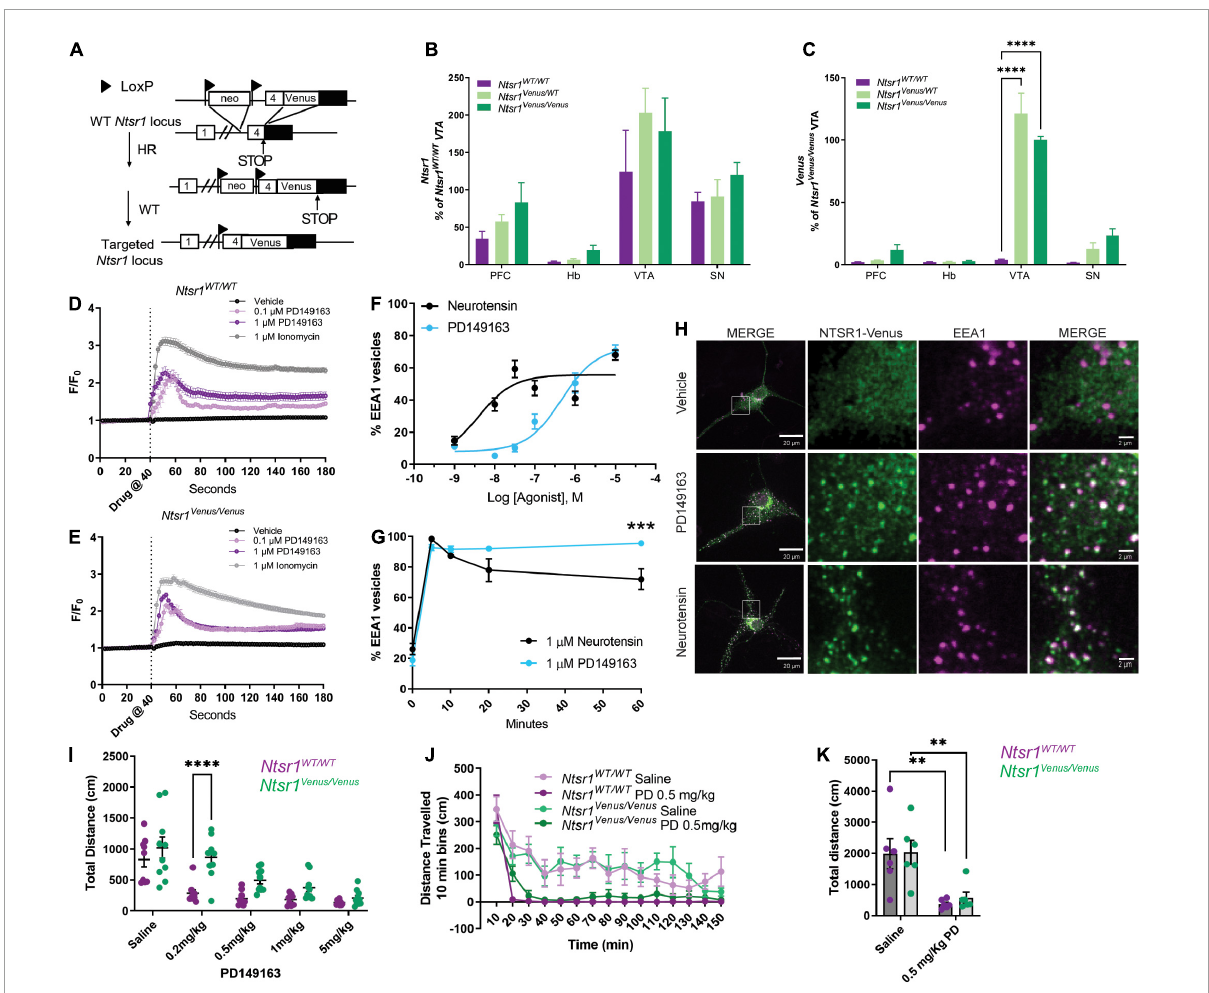
FIGURE2 NTSR1-Venus knock-in mouse generation and functional characterization. (A) Scheme of NTSR1-Venus knock-in mouse generation. Briefly, Venus was knocked-in at the C-terminus of Ntsr1 at the endogenous gene locus. (B,C) mRNA transcript expression is shown across mouse brain regions–prefrontal cortex (PFC), habenula (Hb), ventral tegmental area (VTA), and substantia nigra (SN) in Ntsr1 WT / WT , Ntsr1 KI / WT , and Ntsr1 KI / KI ( n = 3–5 animals per group). (B) Ntsr1 gene expression. (C) Venus gene expression. ∗∗∗∗ p < 0.0001 via 2way ANOVA with a Dunnett’s post-hoc test [significant effect by brain region F ( 3 , 39 ) = 78.35; p < 0.0001; significant effect by genotype F ( 2 , 39 ) = 30.01; p < 0.0001, significant interaction F ( 6 , 39 ) = 18.65; p < 0.0001]. (D,E) Intracellular Ca2+ response was measured in hippocampal neurons from either Ntsr1 WT / WT (D) or Ntsr1 Venus / Venus (E) mice. Hippocampal neurons were treated with vehicle, 0.1 µ M, 1 µ M PD149163, or 1 µ M Ionomycin. Drug was added at 40 s. n = 11–148 cells per condition, each cell was normalized to baseline for the individual cell. (F–H) Agonist profiling by monitoring internalization of NTSR1-Venus in hippocampal primary neurons from Ntsr1 Venus / Venus mice treated with 1 µ M neurotensin or PD149163. The % EEA1 vesicles was calculated by taking the ratio of Venus to EEA1 puncta. (F) Dose-response curves. Neurons were treated with the indicated concentrations of PD149163 or neurotensin and fixed after 5 min. n = 20–23 neurons per condition. (G) Internalization time-course. Hippocampal neurons from Ntsr1 Venus / Venus mice were treated with 1 µ M PD149163 or neurotensin and fixed at indicated timepoints. 0 min received no treatment. n = 13 neurons per condition. ∗∗∗ p = 0.0002 via 2way ANOVA with a Sidak’s post-hoc test [significant effect by time F ( 4 , 111 ) = 122.1; p < 0.0001], significant effect by drug F ( 1 , 111 ) = 5.350; p = 0.0226 with a significant interaction F ( 4 , 111 ) = 5.690; p = 0.0003. (H) Representative images of NTSR1-Venus internalization in hippocampal neurons from Ntsr1 Venus / Venus mice. Cells were treated with vehicle, or NTSR1 agonists 1 µ M PD149163 or neurotensin for 60 min and fixed and stained with anti-Venus (green) or EEA1 (magenta). White boxes indicate 10x magnified area. Scale bars are 20 µ m for the macro view and 2 µ m for the magnified view. (I) 30 minutes following i.p. injection of NTSR1 agonist, PD149163, or saline dose-response locomotor activity effects were assessed by measuring horizontal movement (cm) during 150 min in activity boxes. n = 9 or 10 for Ntsr1 WT / WT and Ntsr1 Venus / Venus mice, respectively. ∗∗∗∗ p < 0.0001 for 0.2 mg/kg Ntsr1 WT / WT vs. Ntsr1 Venus / Venus via 2way RM ANOVA Sidak’s multiple comparisons test [Dose significant effect F ( 4 , 68 ) = 31.61; p < 0.0001, Genotype significant effect F ( 1 , 17 ) = 12.91; p = 0.0022, significant interaction F ( 4 , 68 ) = 3.242; p = 0.0170]. (J) Locomotor activity was measured 30 min following i.p. injection of saline or 0.5 mg/kg PD149163 in tagged and untagged NTSR1 animals. Data shown in 10 min bins of distance traveled. 2way ANOVA Sidak’s multiple comparisons test was not significant for genotype effect [ F ( 1 , 10 ) = 0.005494; p = 0.9424 saline, F ( 1 , 10 ) = 1.261; p = 0.2877 PD 0.5 mg/kg]. (K) Total distance traveled in animals treated with 0.5 mg/kg PD149163 compared to saline treated animals. n = 6 for Ntsr1 Venus / Venus and Ntsr1 WT / WT each. ∗∗ p < 0.01 via 2way ANOVA Sidak’s multiple comparisons test [Saline vs. 0.5 mg/kg, p = 0.0038 and p = 0.0087 for Ntsr1 WT / WT and Ntsr1 Venus / Venus respectively, Drug significant effect F ( 1 , 20 ) = 23.01; p = 0.0001, Genotype effect F ( 1 , 20 ) = 0.1537; p = 0.6992]. Graphs depict the mean ±